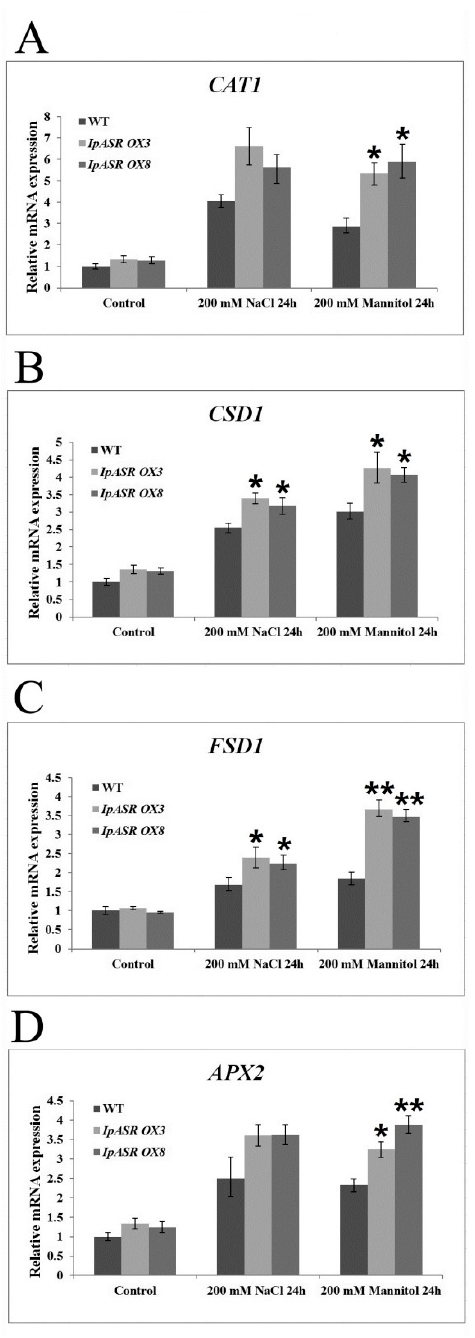
Figure 14. Analysis of the expression levels of reactive oxygen species- (ROS)-related genes in the WT and the transgenic overexpression lines by qRT-PCR under normal and osmotic stress conditions. ( A ) CAT1 ; ( B ) CSD1 ; ( C ) FSD1 ; and ( D ) APX2 . Error bars indicate the SD based on three replicates. Asterisks indicate significant differences from the control (Student’s t -test p values, * p < 0.05 and ** p < 0.01).